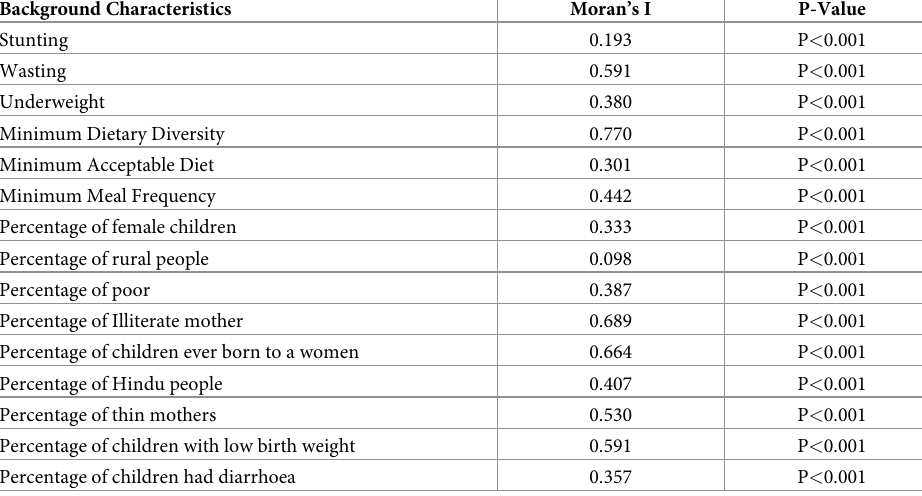
Table 3. Univariate local Moran’s I results for all districts (n = 640) among children aged 6–23 months, India, 2015–16.